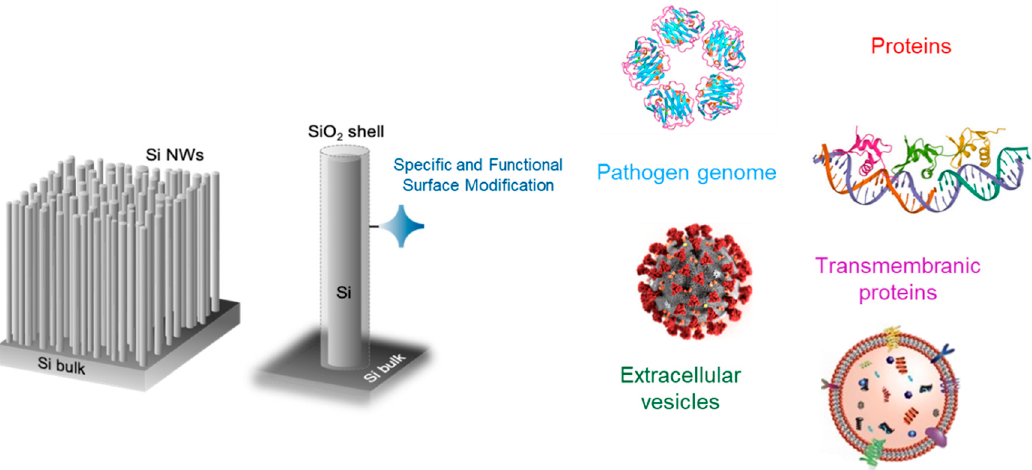
Figure 3. Schematic representation of the selective functionalization adopted for the Si NW optical sensors to detect a variety of different targets.